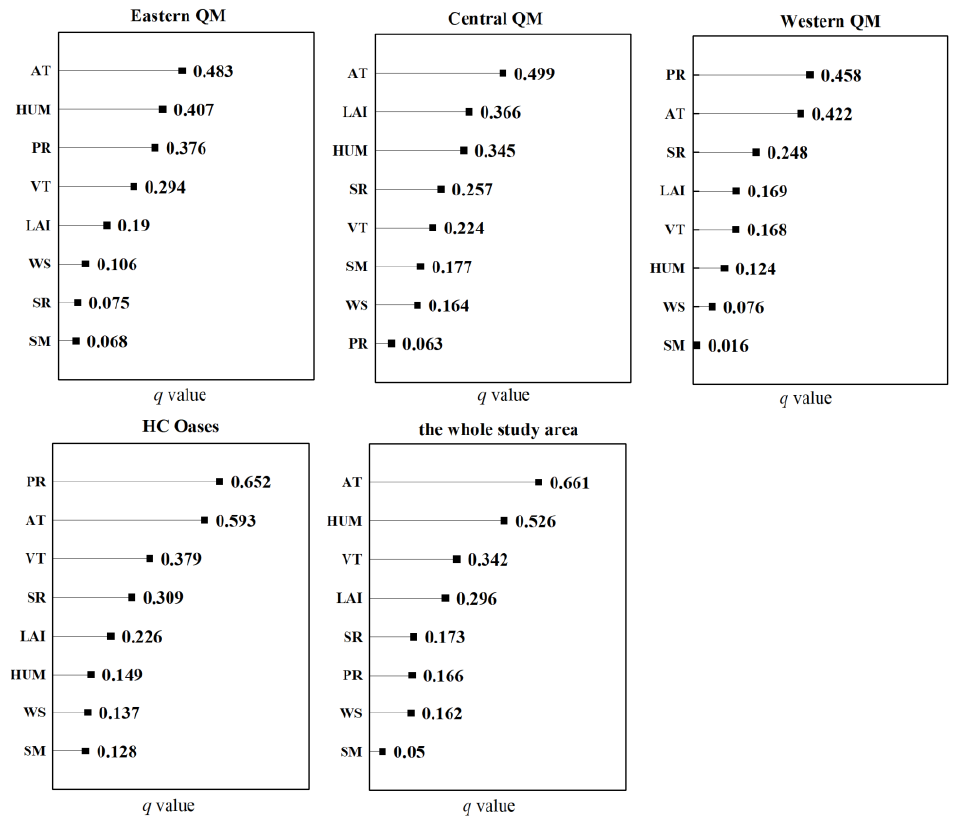
Figure 12. Factor detector-based explanatory power ranking of bio-meteorological variables for WUE in different regions. AT: air temperature; PR: precipitation; HUM: specific humidity; WS: wind speed; SR: shortwave radiation; VT: vegetation type; SM: soil moisture; LAI: leaf area index.